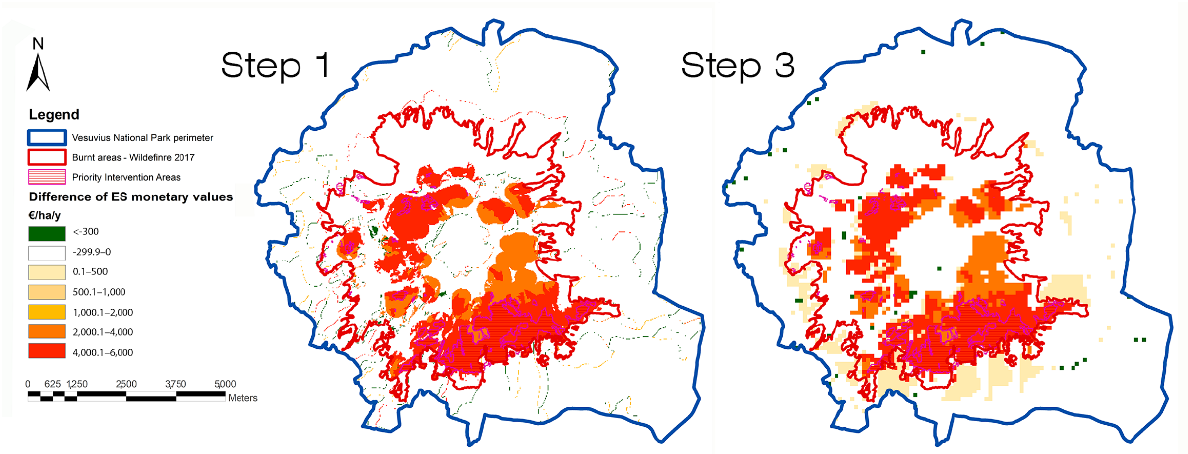
Figure 7. ESs Difference of Monetary Values results in pre-fire and post-fire phases, in Step 1 and Step 3.